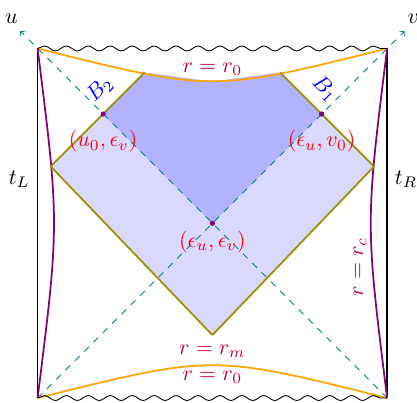
Figure 1 . The intersection of WDW patch with the future interior of an eternal AdS black